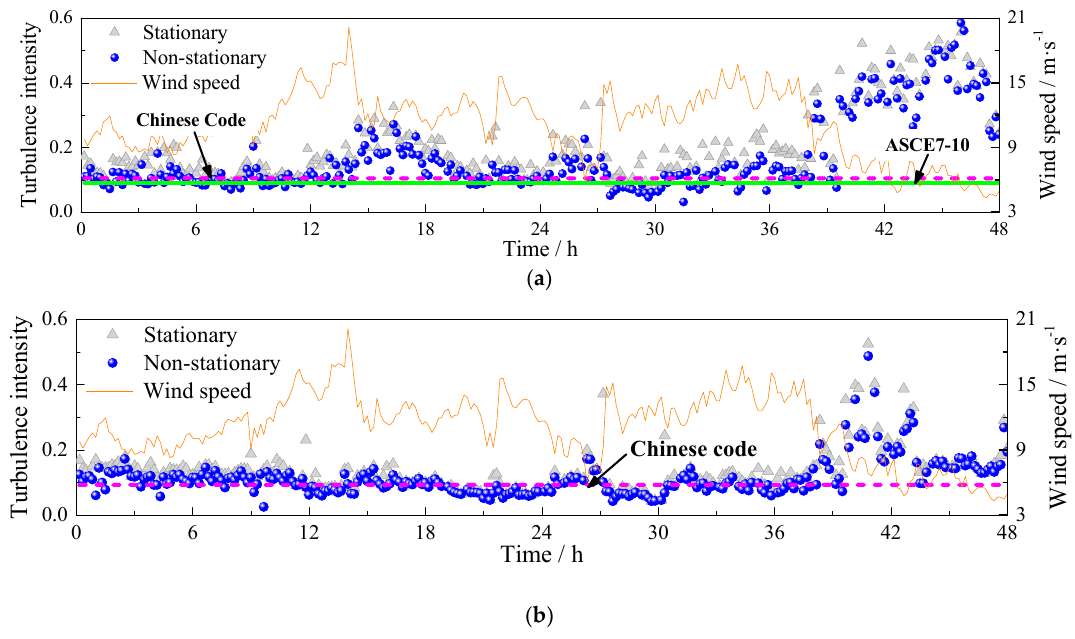
Figure 6. Comparison of stationary and non-stationary turbulence intensities: ( a ) longitudinal case; ( b ) lateral case.